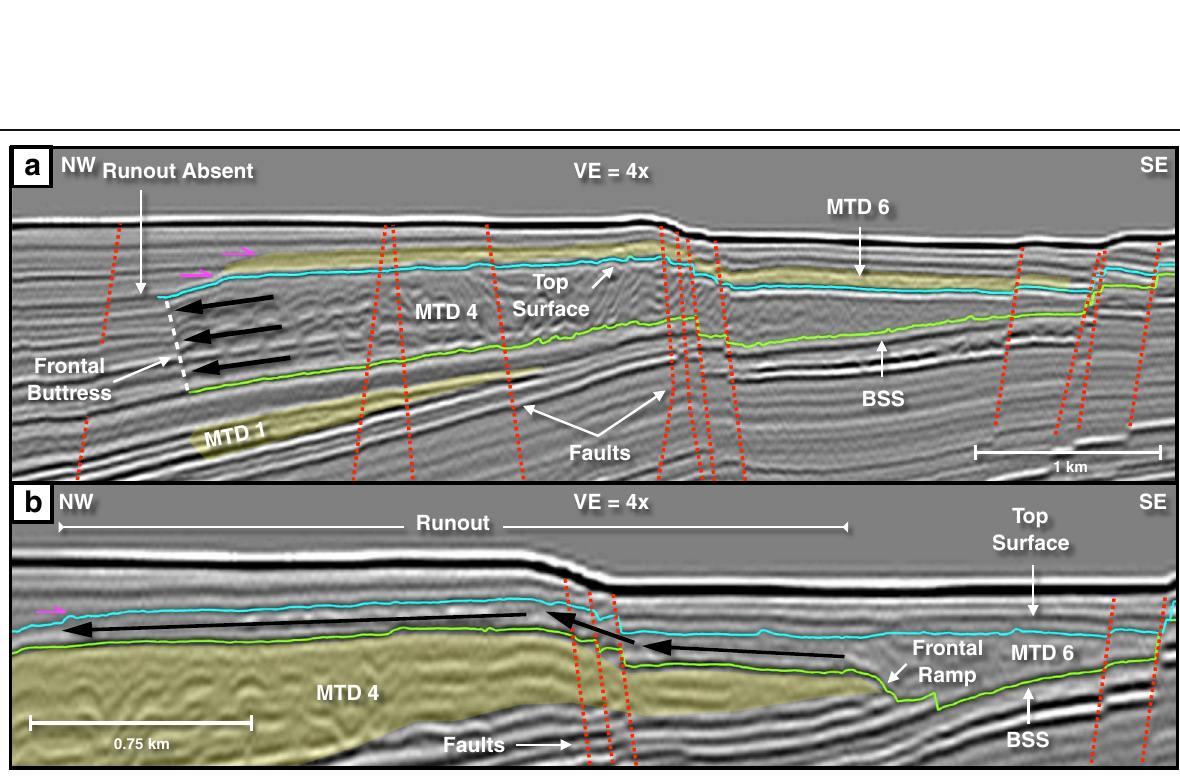
Fig. 3 Frontally confined versus frontally emergent MTDs. Black arrows indicate primary translation direction. Purple arrows indicate onlapping relationships. BSS — basal shear surface. a Frontally confined landslide. The arbitrary seismic line across MTD 4 (see Fig. 6 for location). Note how the landslide mass is buttressed against undisturbed strata. b Frontally emergent landslide. Seismic Inline 2352 across MTD 6 (see Fig. 7 for location). Note the runout of the landslide mass beyond the frontal